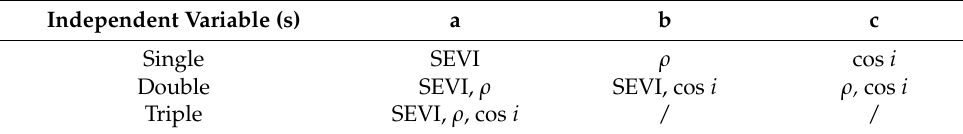
Table 2. Seven inputs of independent